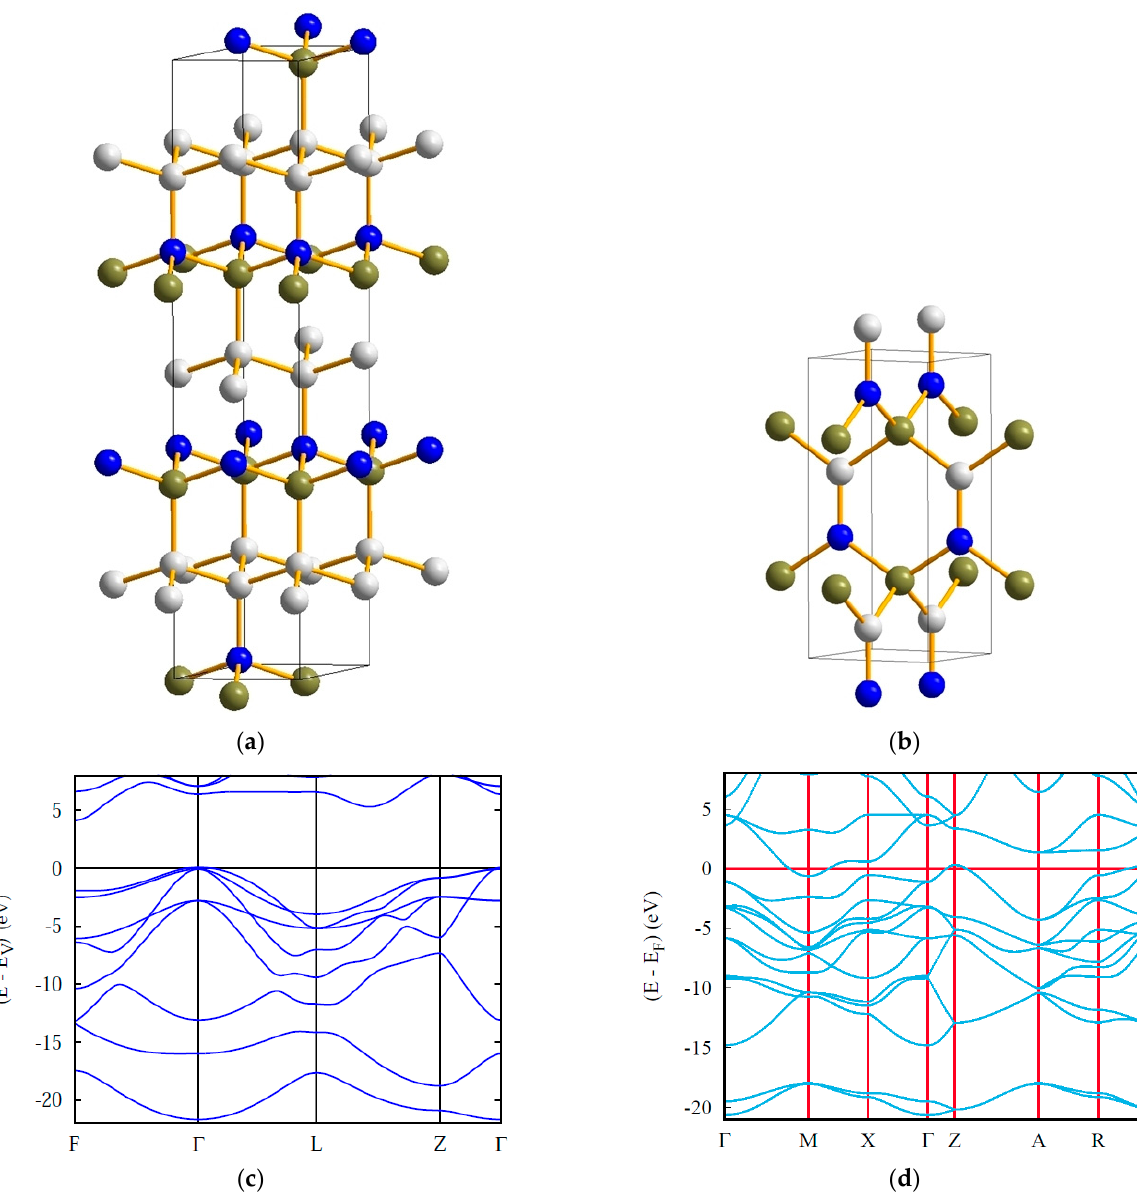
Figure 5. Crystal structures ( a , b ) and electronic band structures ( c , d ) of rhombohedral BC 2 N and tetragonal BCN. Boron, carbon and nitrogen atoms are shown by olive, white and blue spheres, respectively.